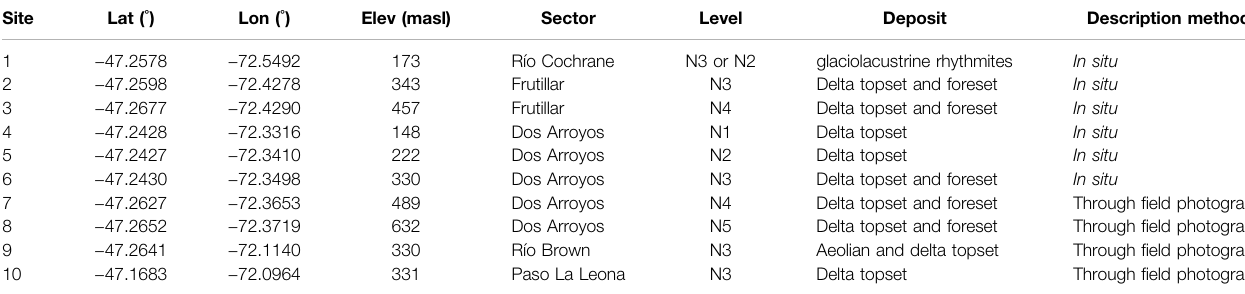
TABLE 1 | Summary of stratigraphic sections. See locations in Supplementary Figure S7